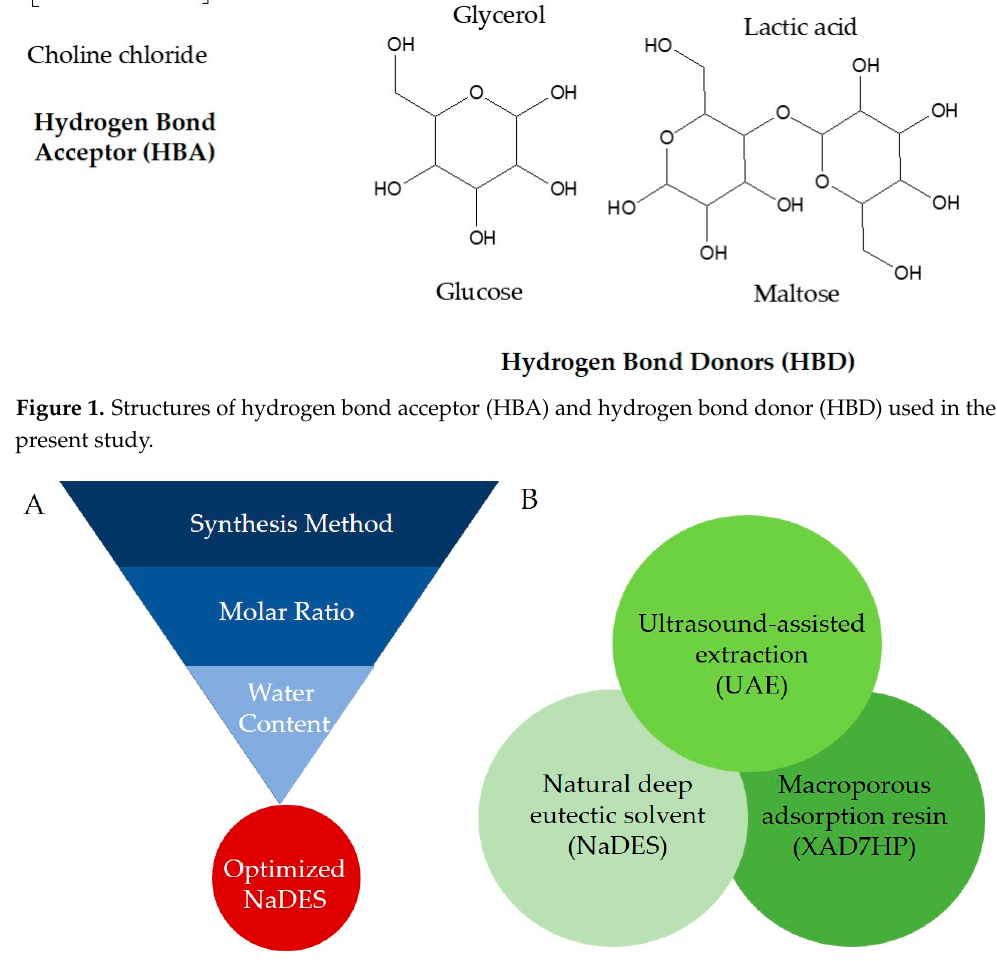
Figure 2. ( A ) General scheme for optimization of NaDES. ( B ) Integration of three key components as a green strategy for flavonoid extraction from oil palm leaves (OPL).